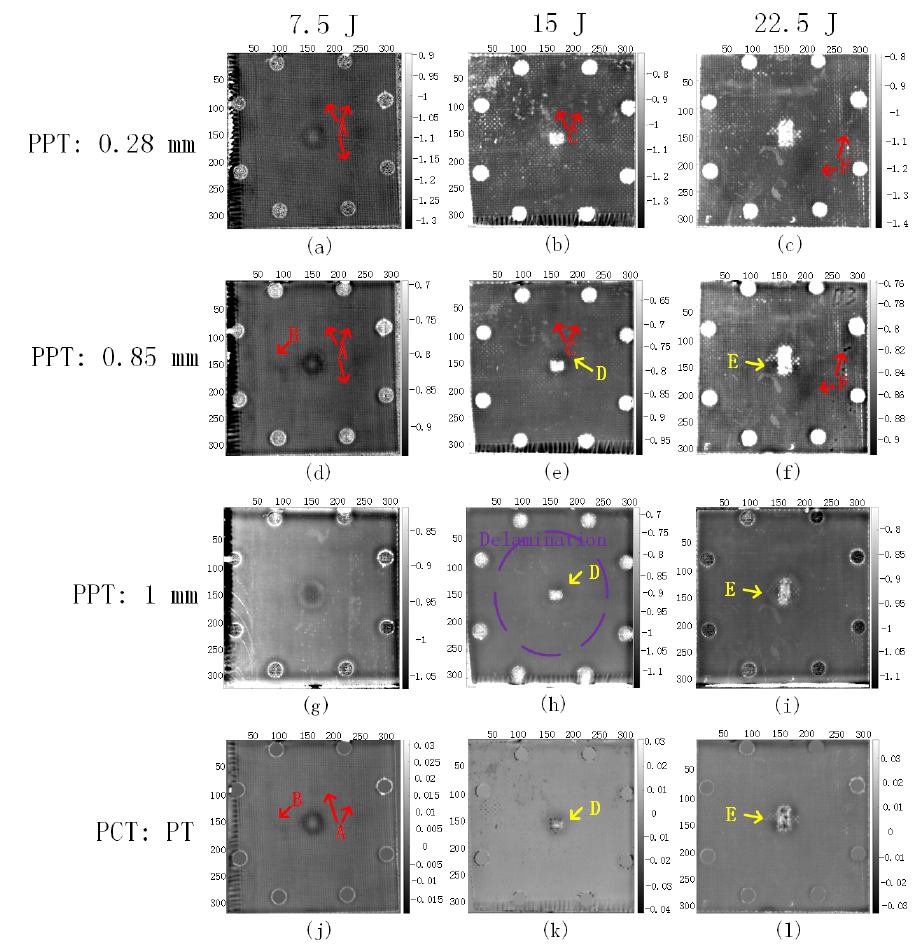
Figure 8. PT for the BFRP laminates after PPT and PCT